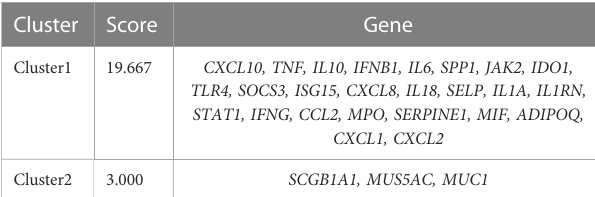
TABLE 1 MCODE clusters of hub genes in co-expression networks in UCEC.